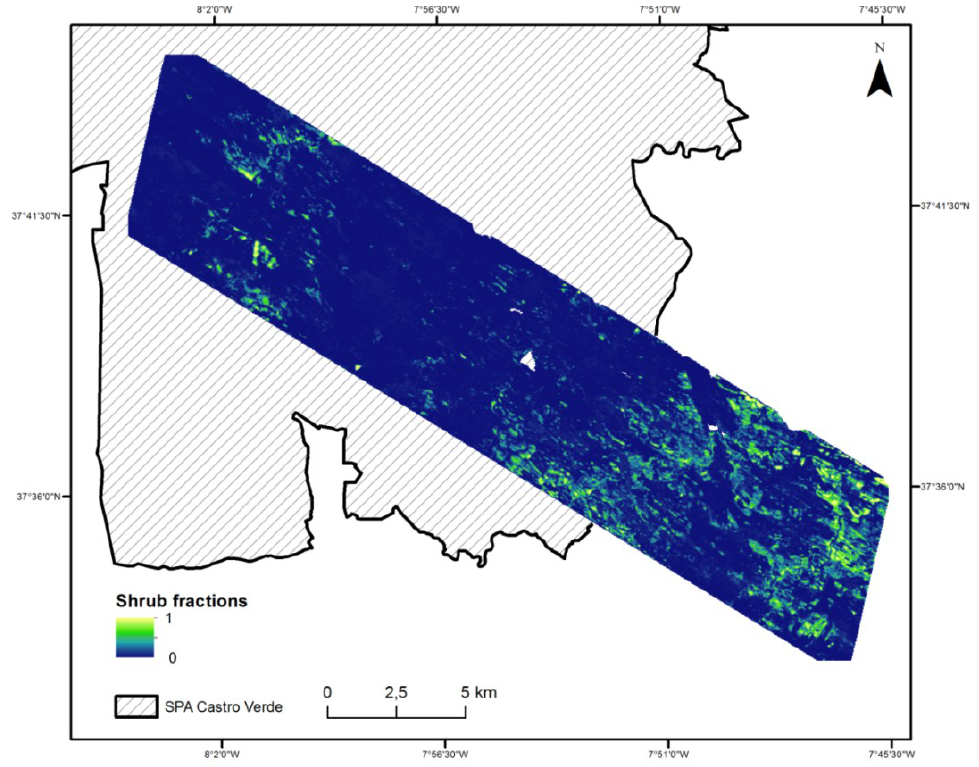
Figure 6. Fractional shrub cover map based on the SVR model trained with 1000 random samples. Yellow to green areas indicate high shrub cover fractions, blue colors low cover fractions.